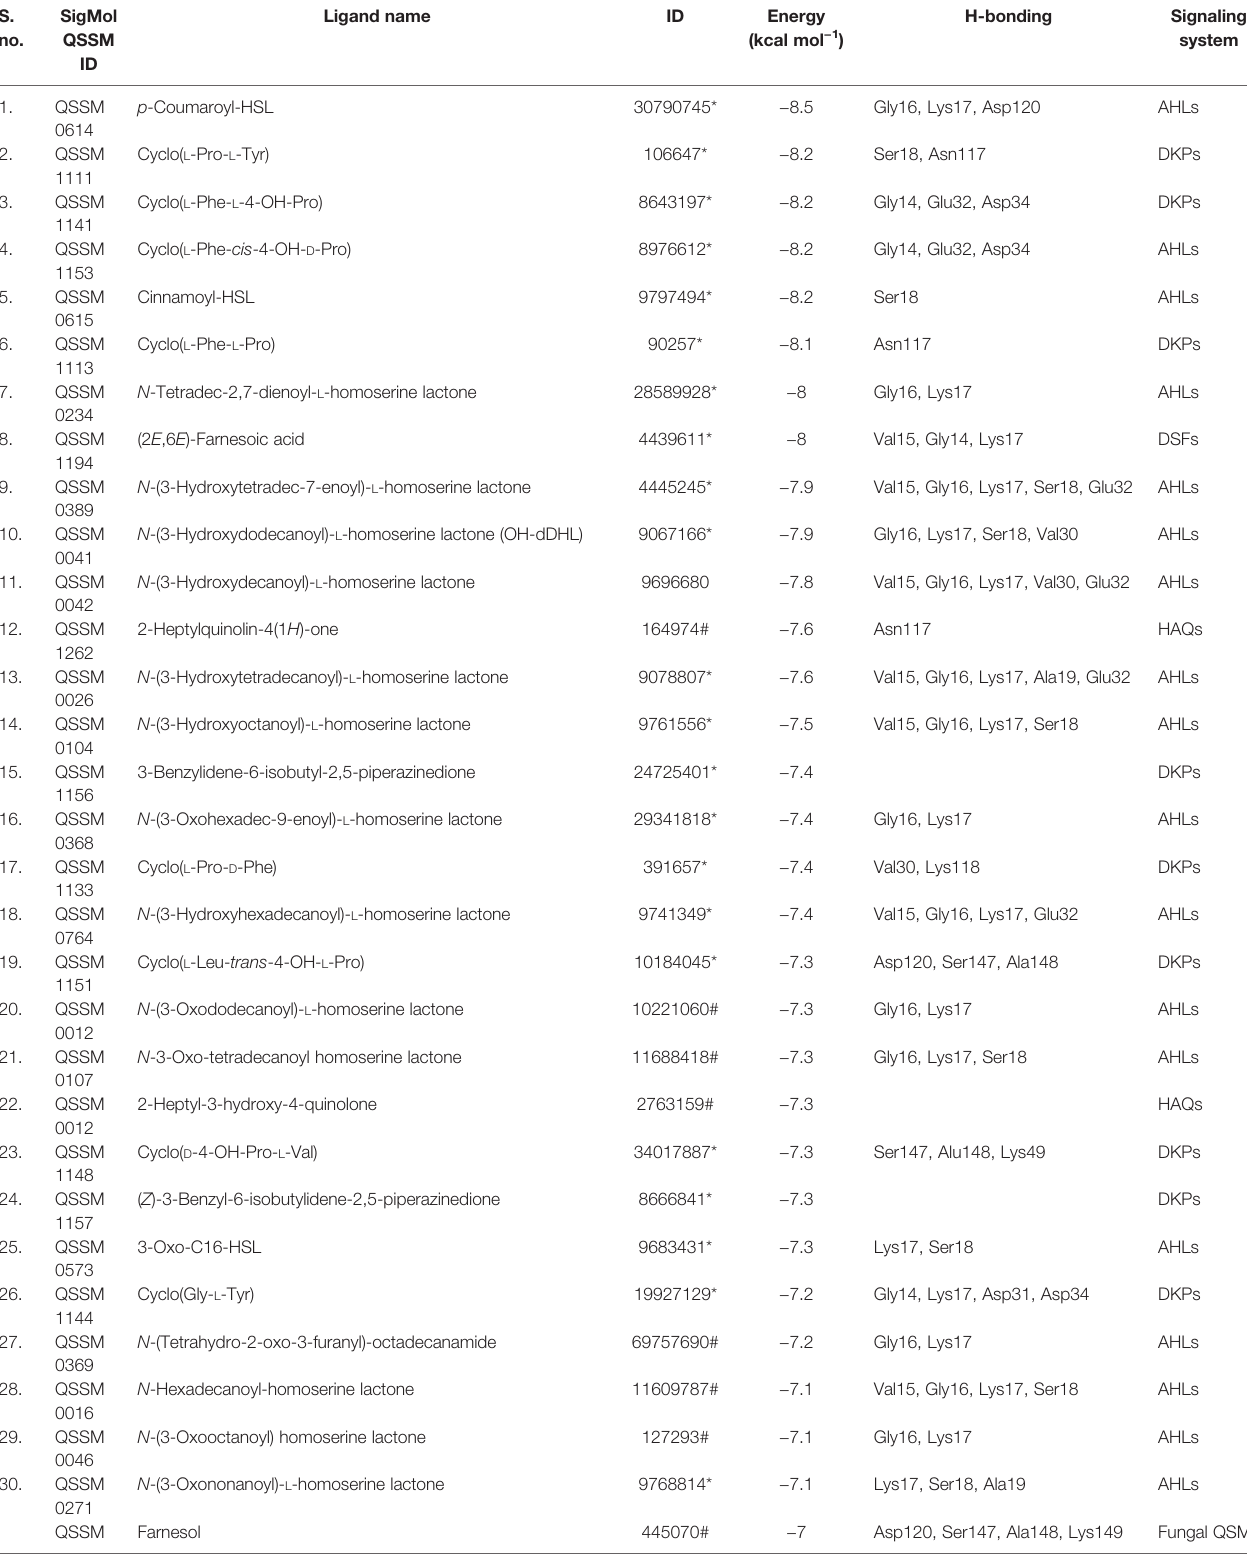
TABLE 2 | List of the 64 screened QSMs with their binding energy and interaction residues against RAS1 as predicted through virtual docking. S.